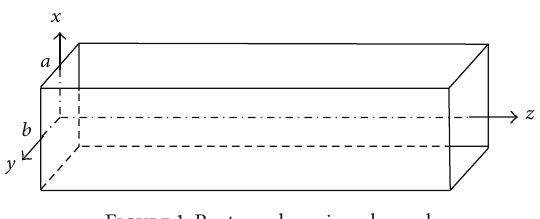
Figure 1: Rectangular